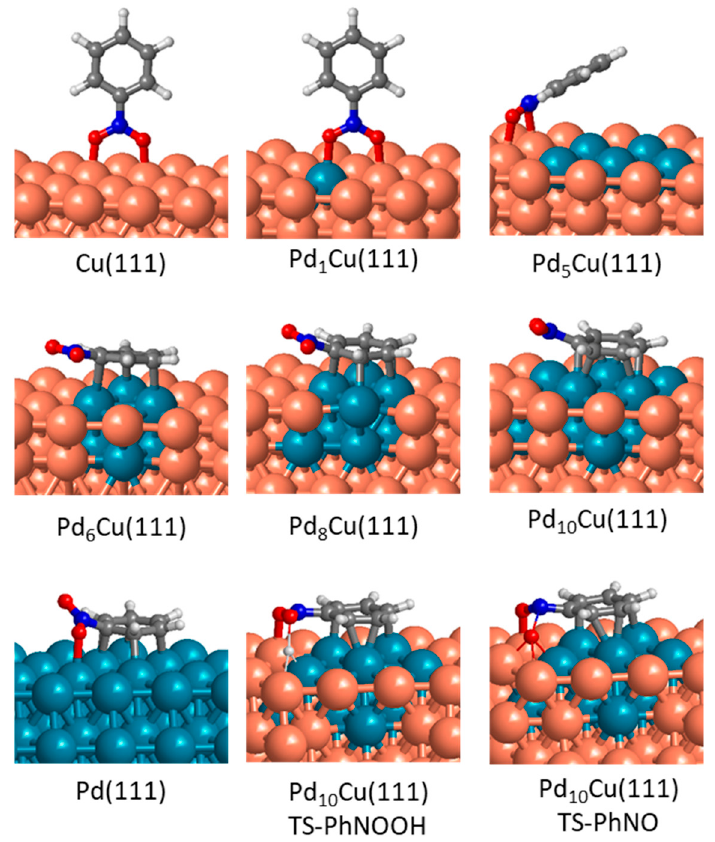
Figure 6. Optimized structures of nitrobenzene adsorbed on mono- and bimetallic catalyst models, and of the transition states for the first hydrogen transfer (TSA) and the first NO bond-breaking (TSB) steps of the mechanism on the Pd 10 Cu(111) model. Cu, Pd, C, N, O and H atoms are depicted as orange, cyan, gray, blue, red and white balls, respectively.